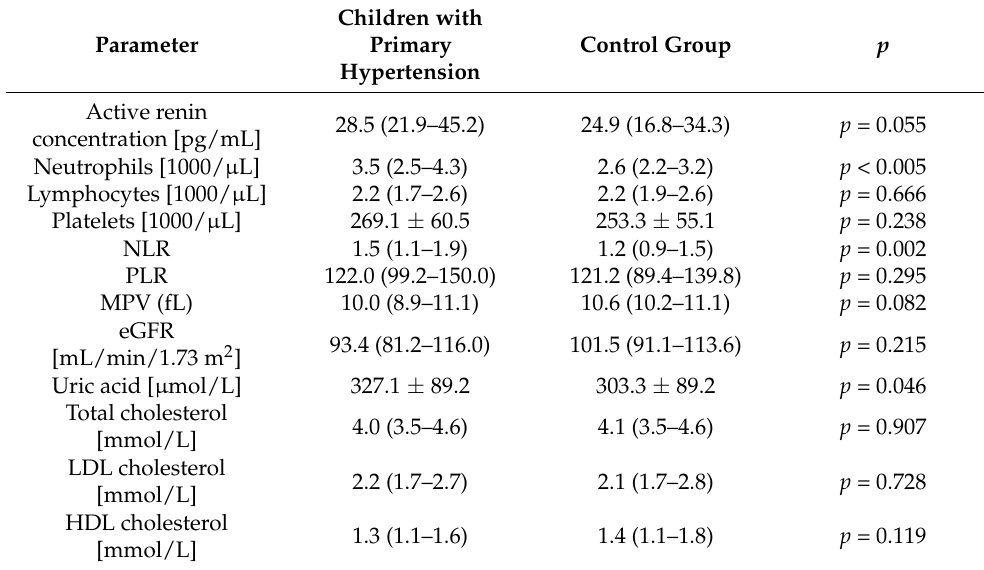
Table 2. Biochemical characteristics of the examined